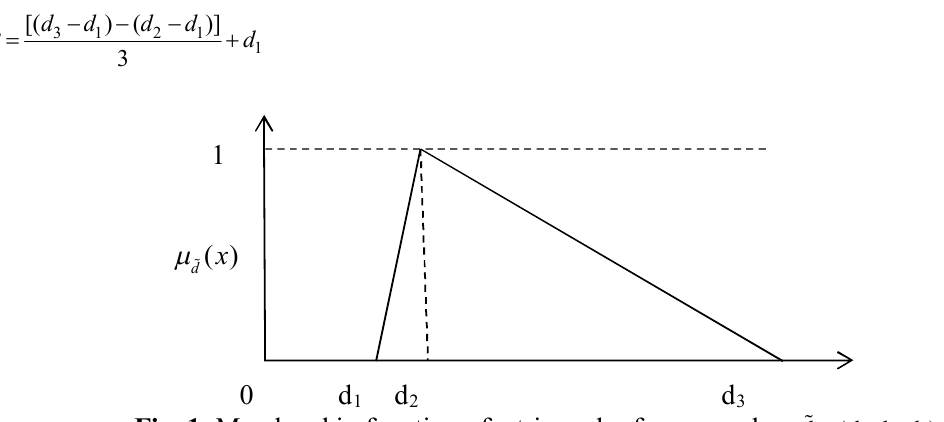
Fig. 1. Membership function of a triangular fuzzy